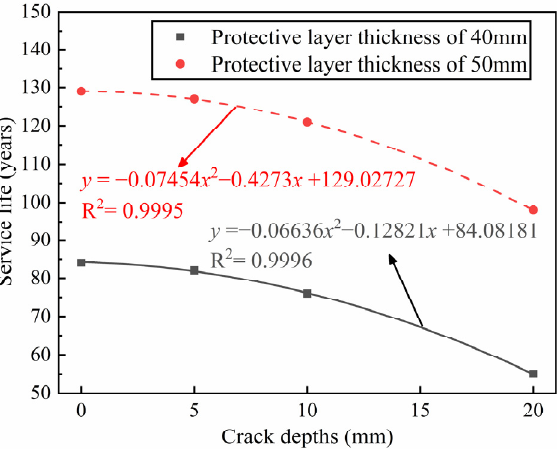
Figure 12. Service life of structures with a different protective layer thickness and crack depth.